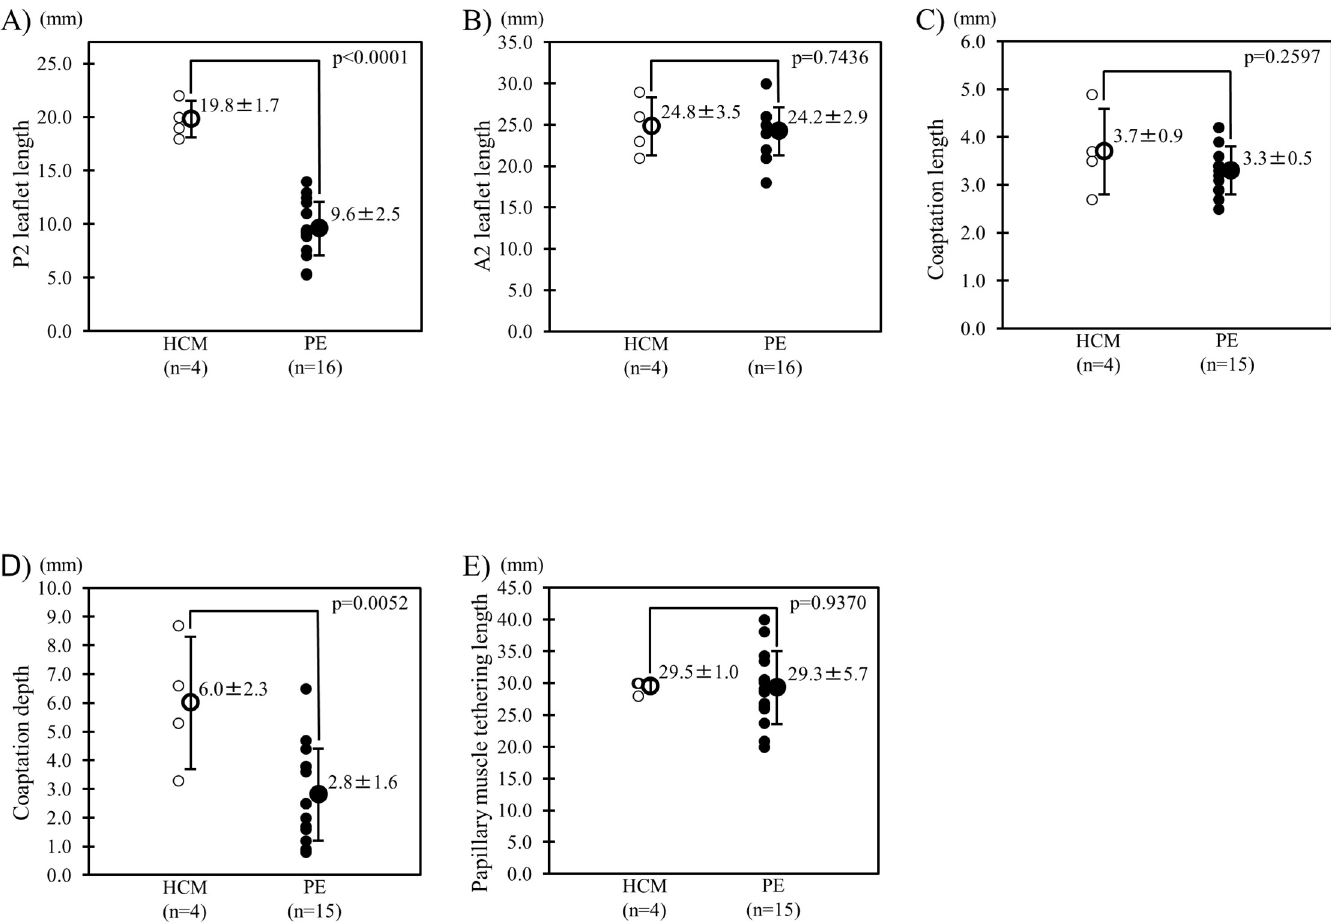
Fig 6. Comparison of the mitral leaflet length, coaptation length and depth, and papillary muscle tethering length betwee the patients with PE and HCM. Comparison of the actual P2 (A), A2 length (B), coaptation length (C) and depth (D), and papillary muscle tethering length (E) between the patients with PE and HCM older than 16